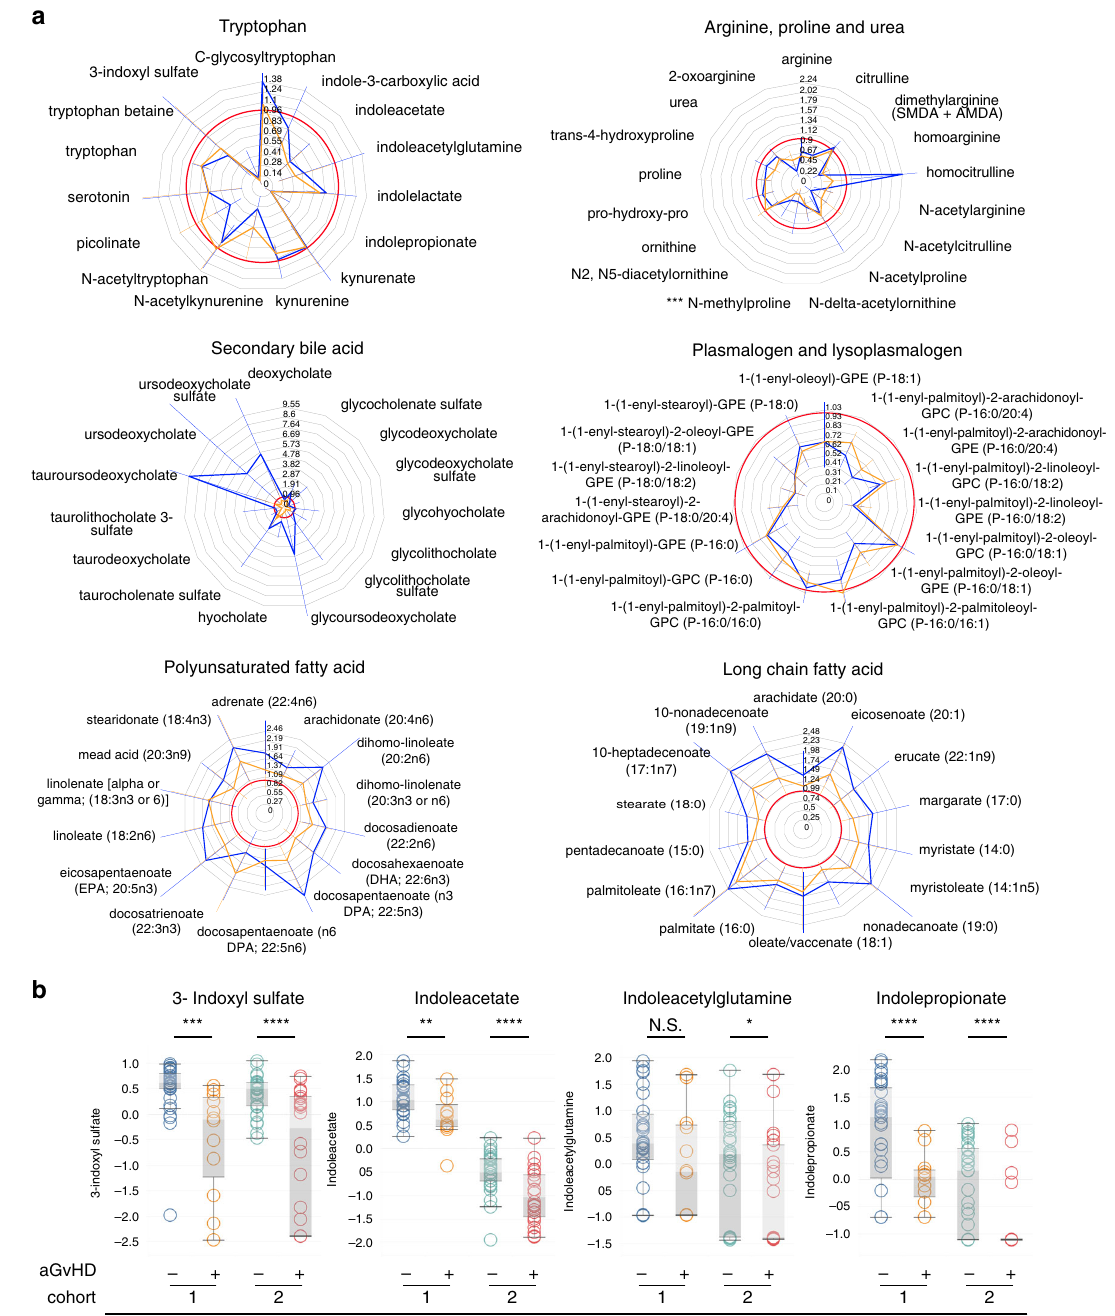
Fig. 7 Pathways associated with aGVHD involve microbiota-derived aryl hydrocarbon receptor ligands. Metabolites from the six most frequently involved sub-pathways at GvHD onset were compared between recipient with and without GvHD in both cohorts (blue: monocentric cohort 1; orange: multicentric cohort 2; red line: ratio = 1). Radar plots represent the ratio of the mean value of each metabolite in recipients with GvHD compared to those without GvHD, with bars corresponding to the standard deviation of the mean value in both cohorts. The red line corresponds to a ratio of 1. b Within the tryptophan pathway, the four metabolites that were decreased at GvHD onset were microbial-derived indole compounds that may act as aryl hydrocarbon receptor (AhR) ligands. Logarithm of the individual values are represented for both cohorts in patients with or without GvHD and values were compared with a Student test. Each box represents the median value with interquartile range, whiskers described minimal and maximal values. * p < 0.05, ** p < 0.01, *** p < 0.001, **** p <